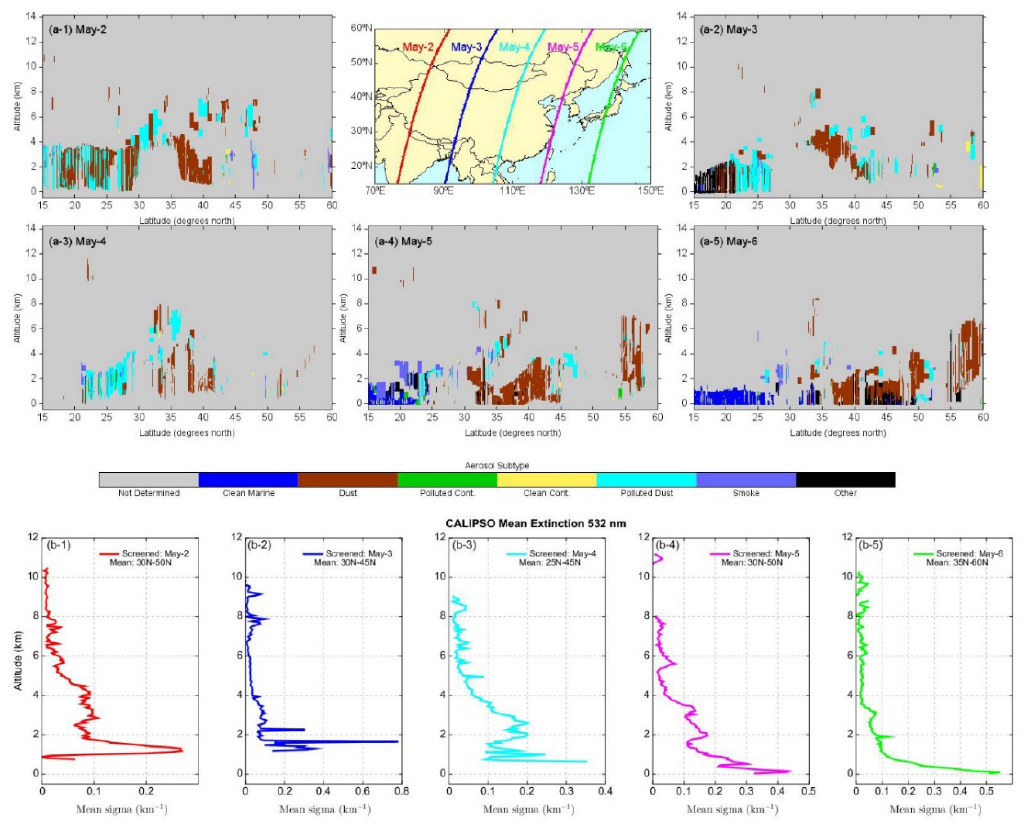
Figure 5. ( a ) Vertical profiles of daily aerosol types on the CALIPSO observation track on 2–6 May 2017. ( b ) Vertical profiles of the mean aerosol extinction coefficient on the CALIPSO observation track on 2–6 May 2017. Different colors represent the observed track on different dates (nighttime observation).